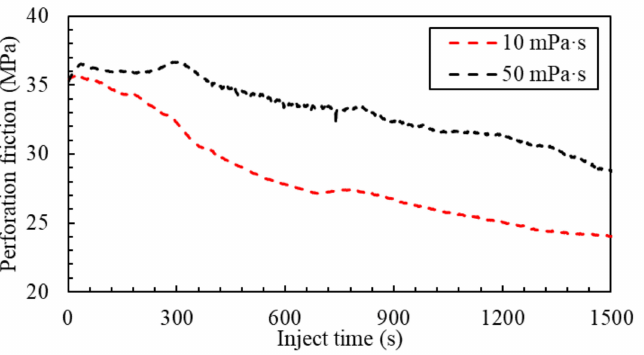
Figure 9. Perforation friction vs. injection time at different fluid viscosities (proppant dosage of 6 m 3 ).